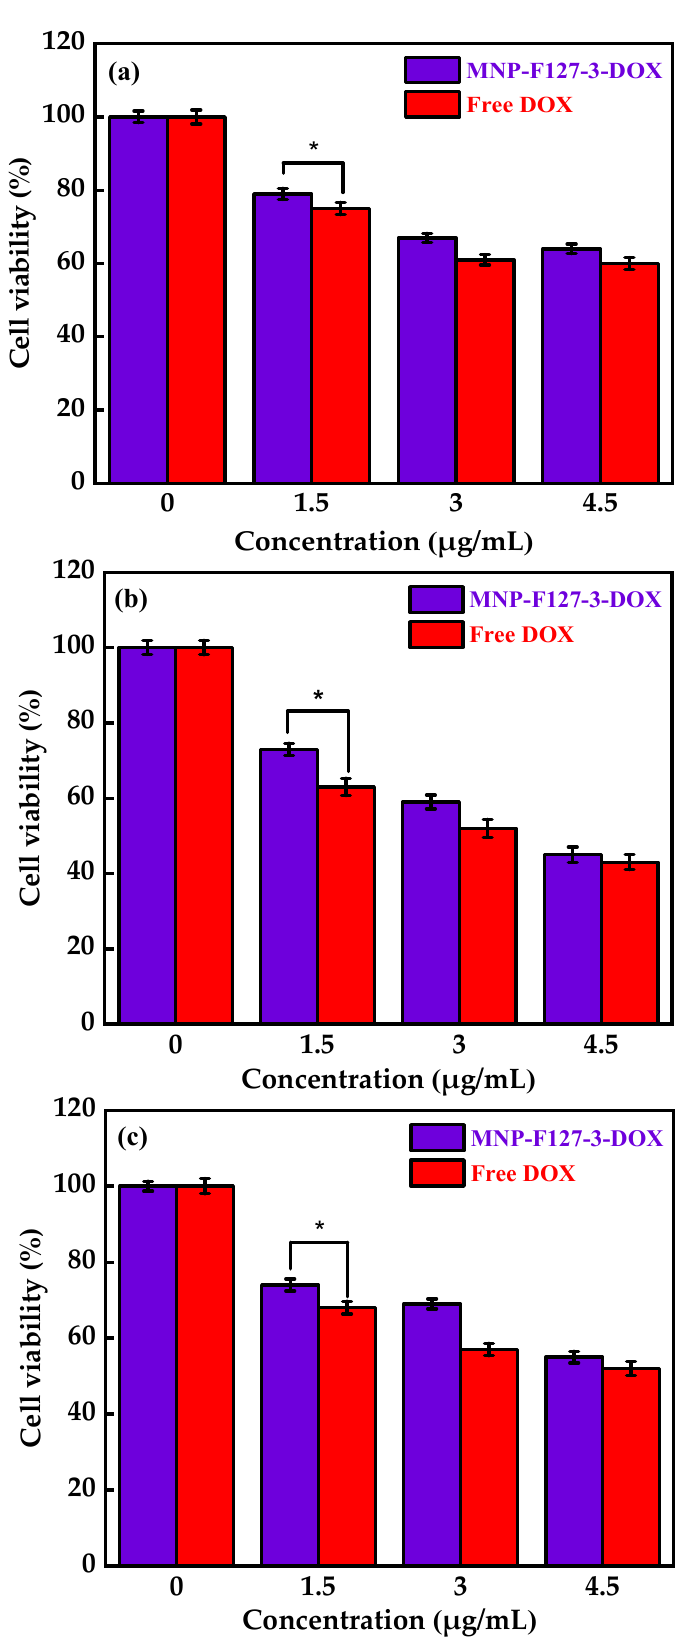
Figure 8. Cell viability of MNP-F127-3-DOX and free DOX over the HepG2 cell line at ( a ) 24, ( b ) 48, and ( c ) 72 h, respectively. * p < 0.05 is known to be statistically significant.